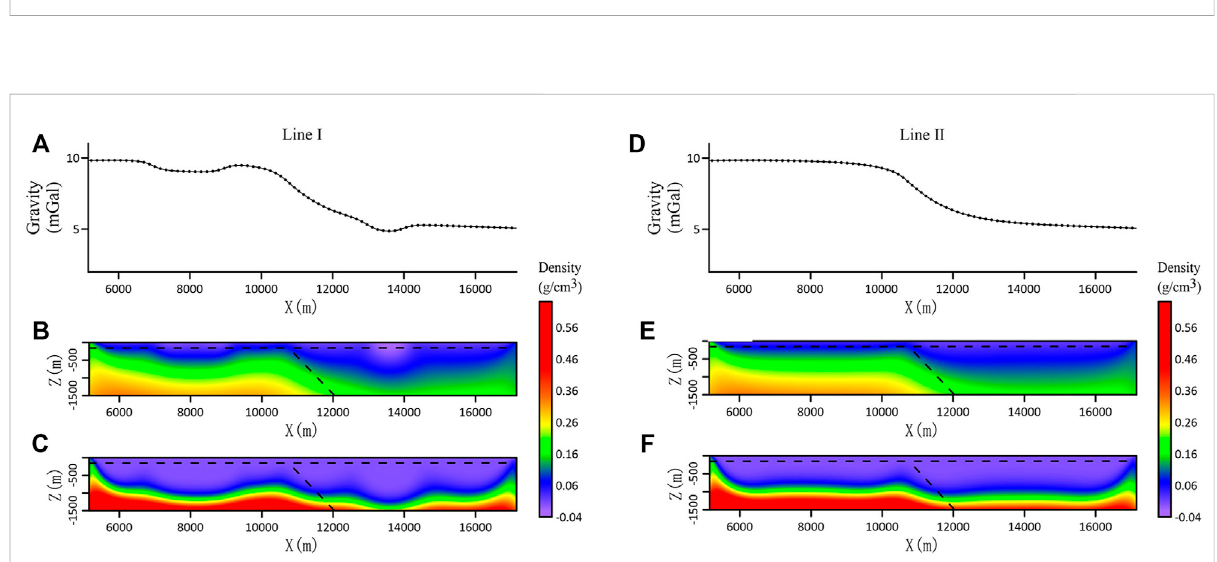
FIGURE 3 Normalfaultfracturemodelandforwardmodeling fi eld. (A) Modelz= − 200 mplanedistributionmap. (B) ModelIlinepositionpro fi le; (C) Model II line position pro fi le. (D) Forward gravity modeling results of the model. (E) Forward results of the horizontal gradient in the x-direction of gravity in the model.